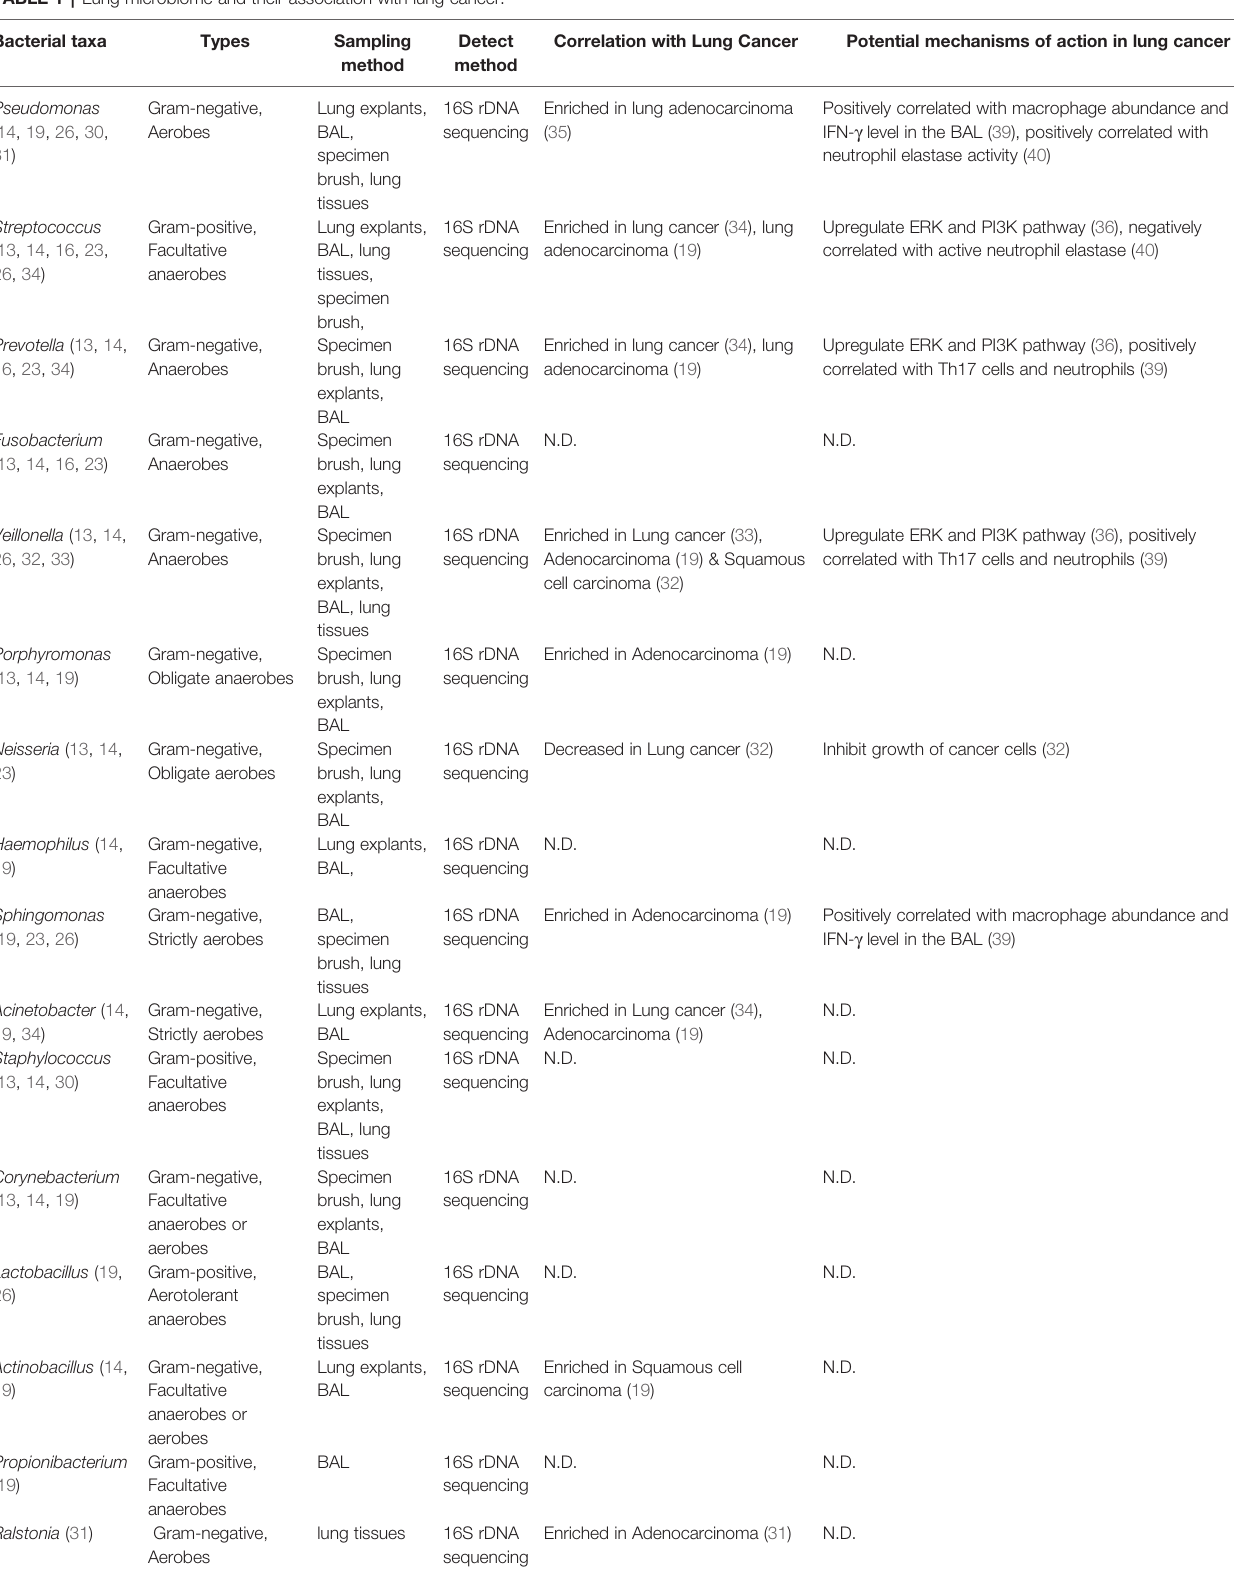
TABLE 1 | Lung microbiome and their association with lung cancer. Bacterial